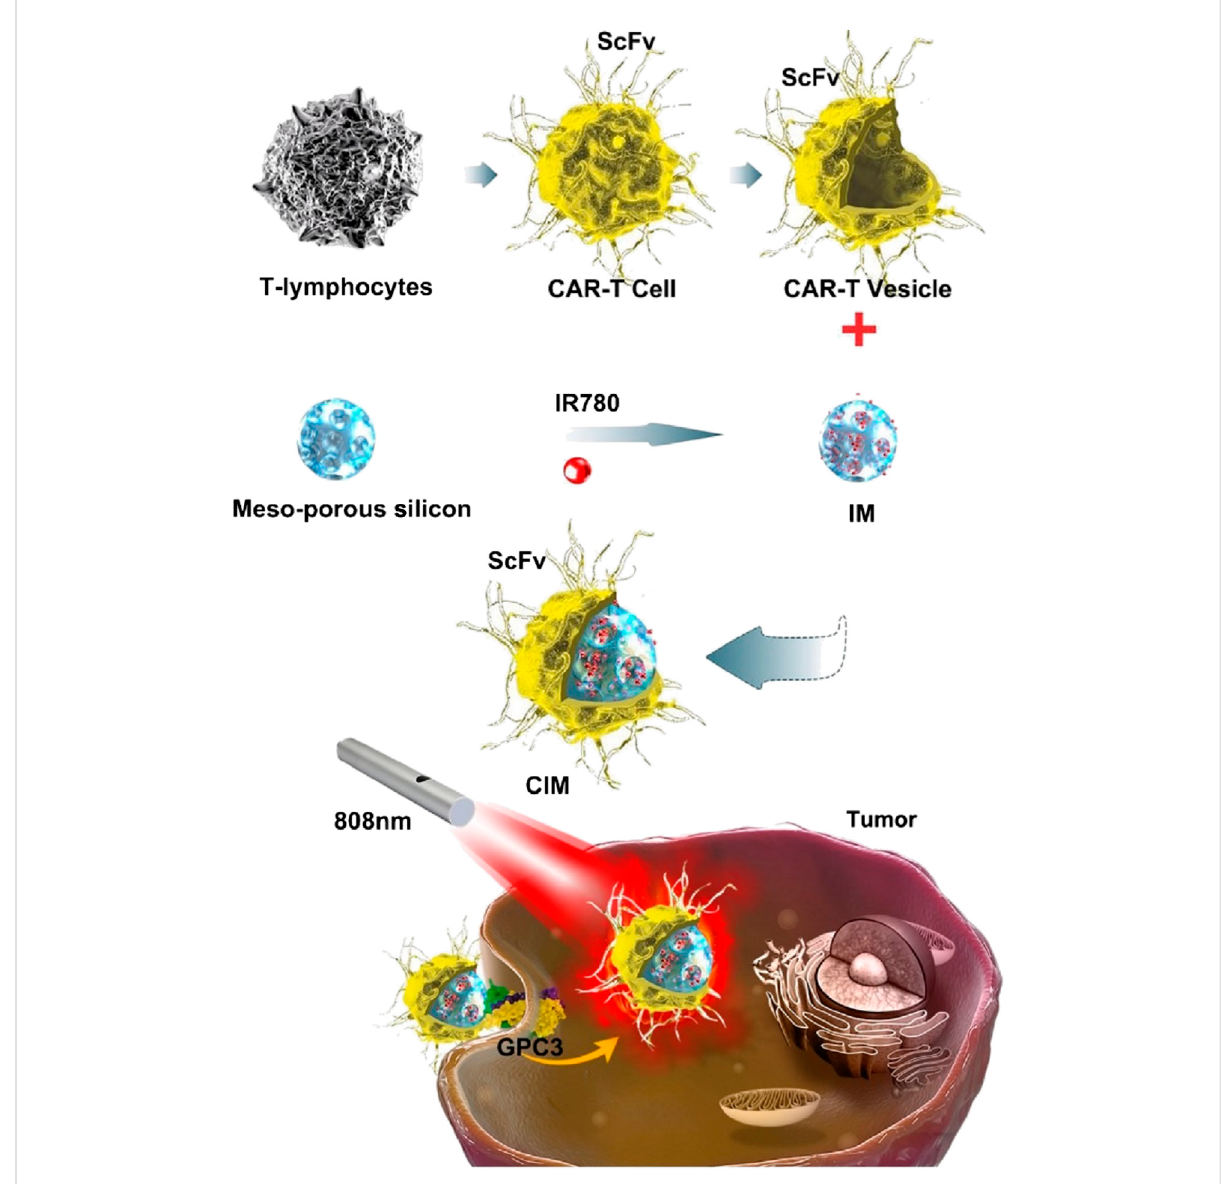
FIGURE 4 Schematic illustration of chimeric antigen receptor-T (CAR-T) membrane coated nanoparticles for tumor photothermal therapy. CAR-T: chimeric antigen receptor-T; CIM: CAR-T cell membrane-coated nanoparticle; GPC3: Glypican-3; IR780: IR780 iodide; IM: IR780-loaded MSN; MSN:mesoporoussilicananoparticle;ScFv:single-chainvariableregion(derivedfrommonoclonalantibodyheavyandlightchainsandexpressedon the cell membrane of CAR-T cells). Reproduced with permission from reference (Ma et al., 2020). Copyright © The